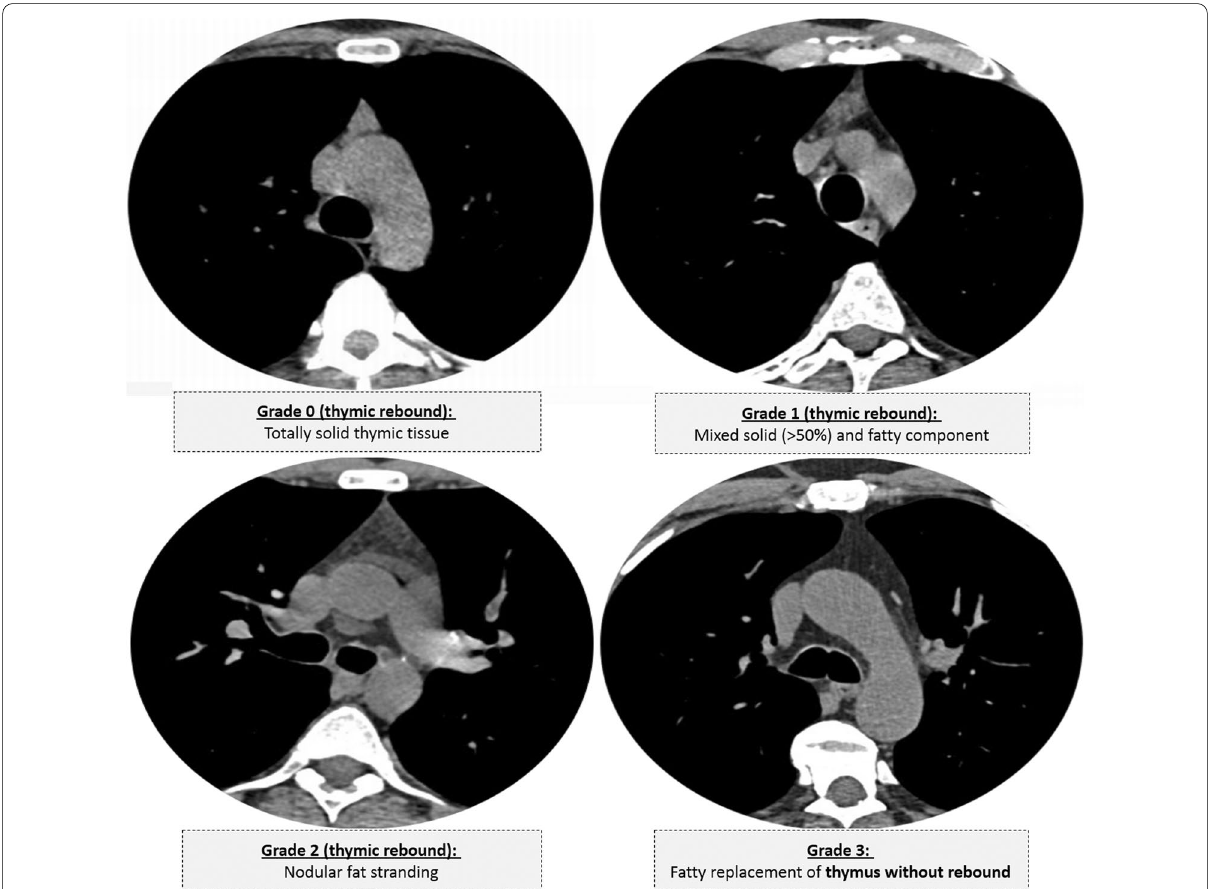
Fig. 2 Thymic CT-grading (according to Cuvelier et al. [5]) with provided examples for different CT images with thymic CT-grades (0 to 3) from the current